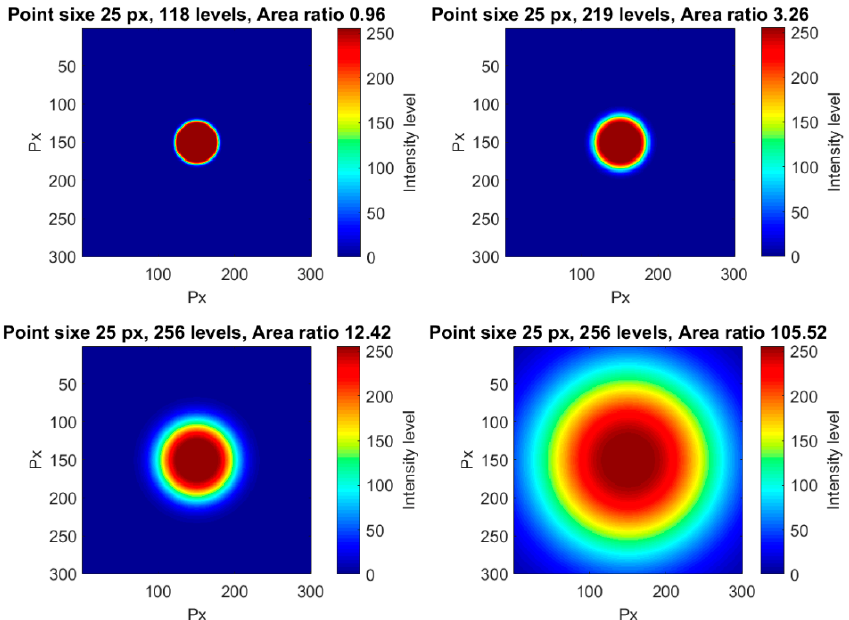
Figure 13. Four different examples of points with the same point size and different surrounding gradients.